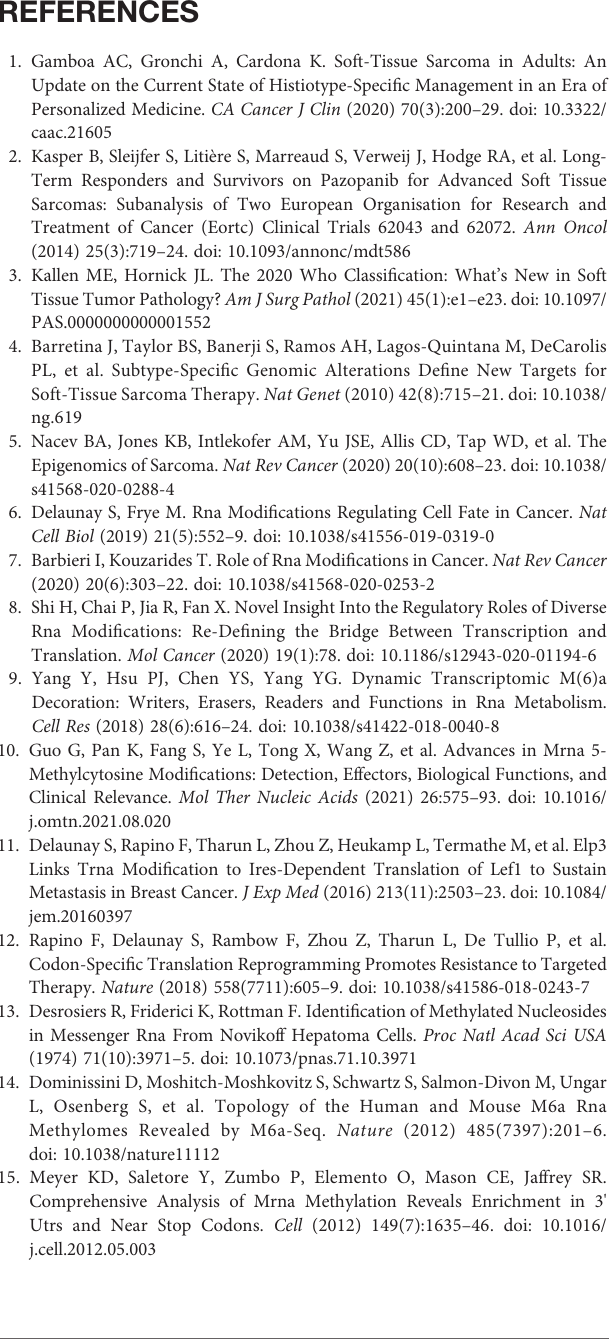
Supplementary Figure 4 | Analysis of RNA modi fi cation Regulator Clusters in STS. (A – D) Consensus clustering based on RNA modi fi cation regulators ( K = 2-5). (E) Consensus cumulative distribution function (CDF) Plot based on RNA modi fi cation regulators. (F) Delta area plot of consensus clustering based on RNA modi fi cation regulators. (G) The GSVA illustrating pathway enrichment among distinct Regulator Clusters. Supplementary Figure 5 | Analysis of Regulator gene subtypes in STS. (A – D) Consensus clustering based on regulator-related DEGs ( K = 2-5). (E) The CDF Plot basedonthe54 RNA modi fi cationregulator-relatedDEGs. (F) Delta area plot of consensus clustering based on the DEGs. (G, H) The GSVA illustrating